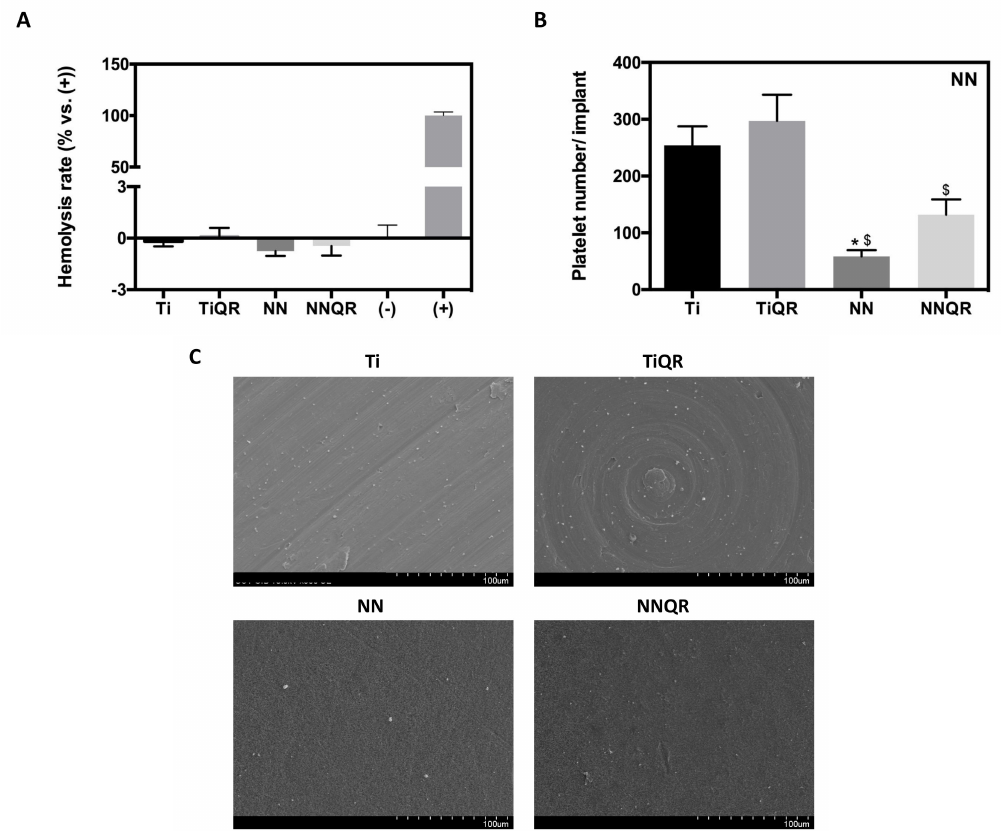
Figure 5. Hemocompatibility and platelet adhesion. ( A ) Hemolysis rate induced by the surfaces after 1 h of incubation, expressed as % vs. ( + ) that was set to 100%. Blood incubated with water is considered ( + ), and blood incubated with PBS is considered ( − ) ( n = 6). ( B ) Platelet adhesion after 2 h on the di ff erent surfaces ( n = 8). ( C ) Representative SEM images of human platelets adhered to the di ff erent surfaces. Values represent the mean ± S.E.M. Results were statistically compared by Kruskal–Wallis. * p < 0.05 versus Ti; $ p < 0.05 versus TiQR. NN indicates the e ff ect of nanostructuration ( p < 0.05) as assessed by